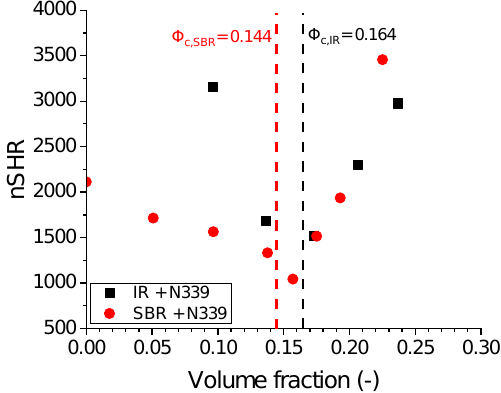
Figure 2. The normalised superharmonic resonance for carbon black (CB)-filled styrene-butadiene rubber (SBR) and isoprene rubber (IR) compounds. The percolation thresholds were obtained by Rubber Process Analyzer